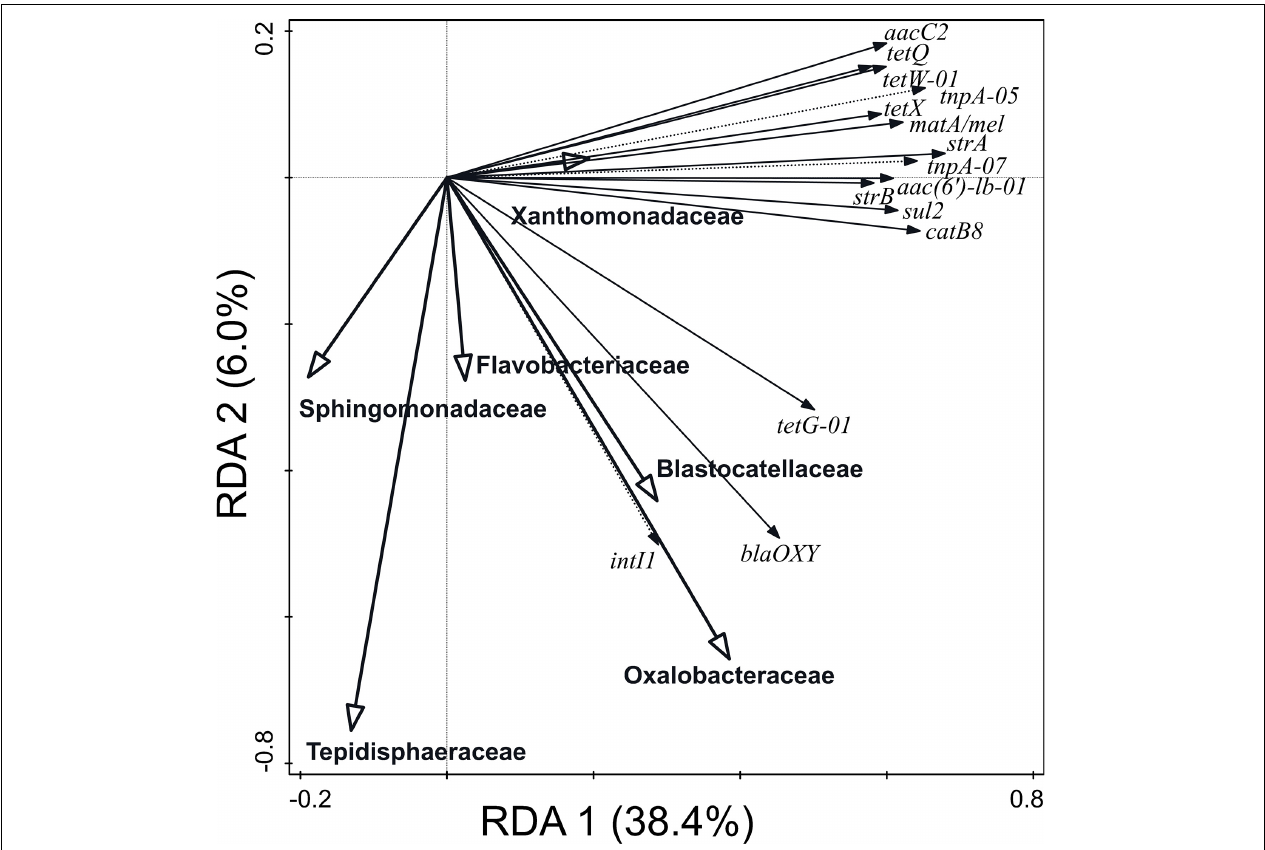
FIGURE 5 | Biplot of the RDA performed with the 30 most abundant families (explaining 65.8% of the variation in ARG and MGE-gene abundances) as explanatory variables, the relative abundance of ARGs and MGE-genes as response variables, and field and current crop as covariates. Only statistically significant explanatory variables and response variables with the best fit are